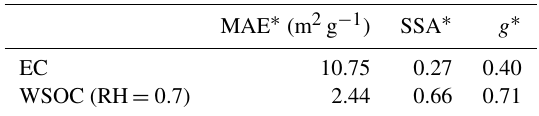
Table 3. Optics for EC and WSOC (RH = 0 . 7) in the